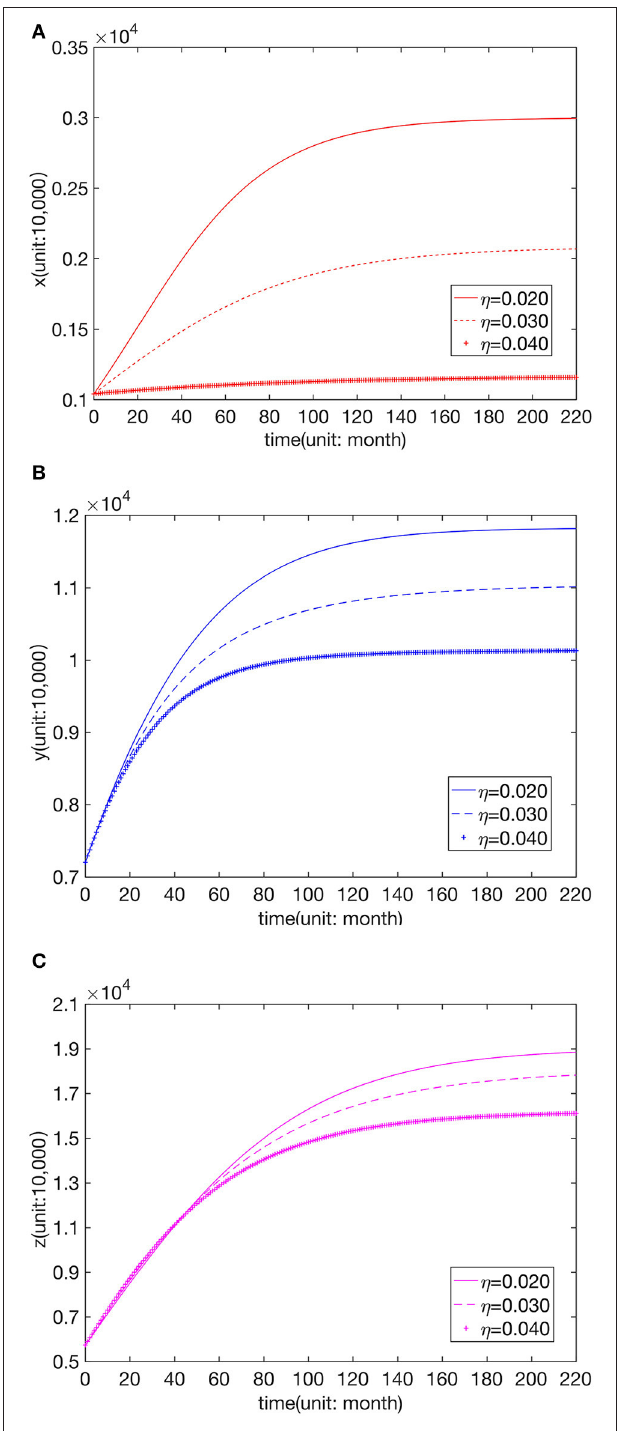
FIGURE 6 | Effect of parameter value m f on the number of visits to (A) FLHs, (B) SLHs, and (C)